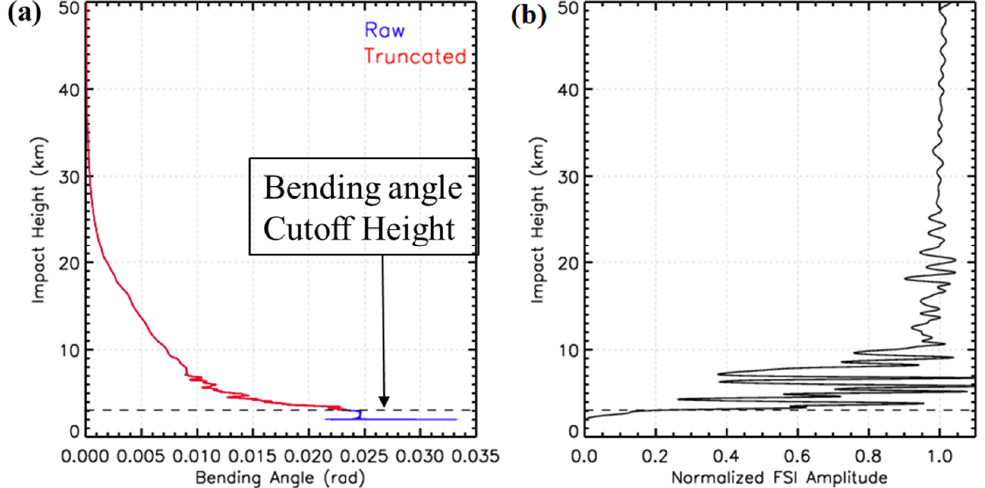
Figure 7. ( a , b ) Illustration of the impact parameter cutoff point in the FSI